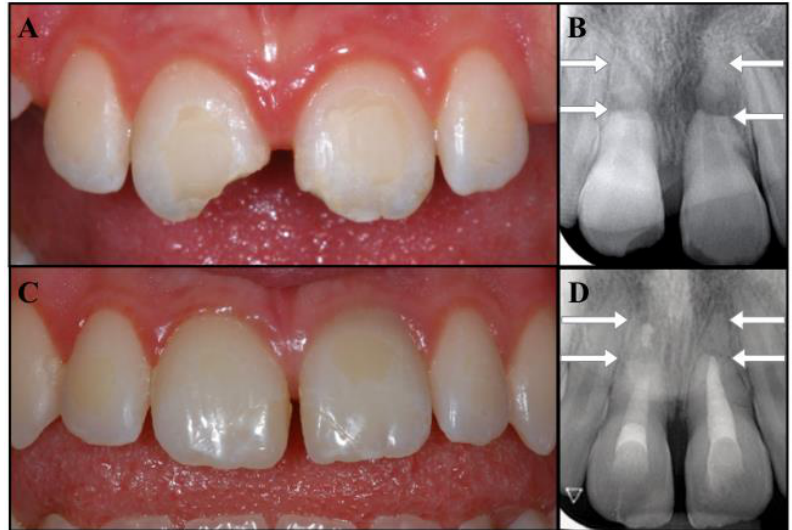
Figure 4. ( A , B ) Clinical photograph and intraoral radiographs of teeth #1.1 and #2.1 at the initial stage of treatment (replantation) and at the 30-month follow-up. ( C , D ) The images show good coronal restorations, mild signs of discoloration in the cervical portion of tooth #2.1, healing in the fracture lines, a healthy periapex.